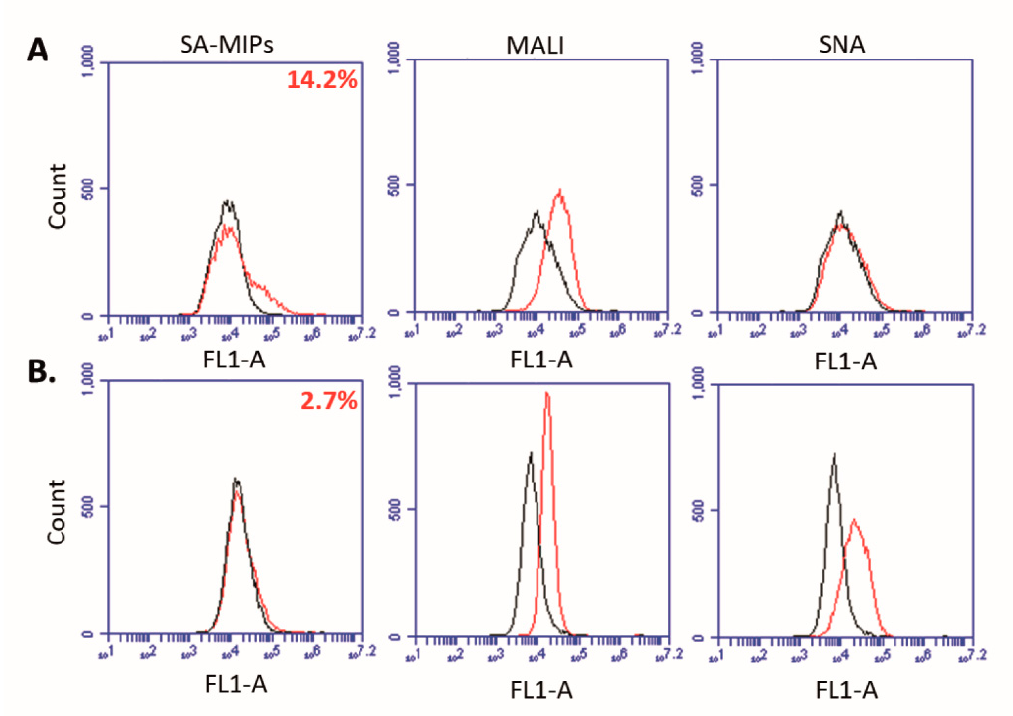
Figure 1. Histograms presenting the mean fluorescence intensity (MFI) for cell staining with sialic acid-molecularly imprinted polymers (SA-MIPs) or the lectins MALI ( α -2,3-specific) and SNA ( α -2,6-specific) for both MCF-7 cells ( A ) and MDAMB231 cells ( B ). The black traces show the unstained samples, while the red traces show the stained samples. The experiment is repeated at least three times with similar results. The histograms show results from one representative experiment.